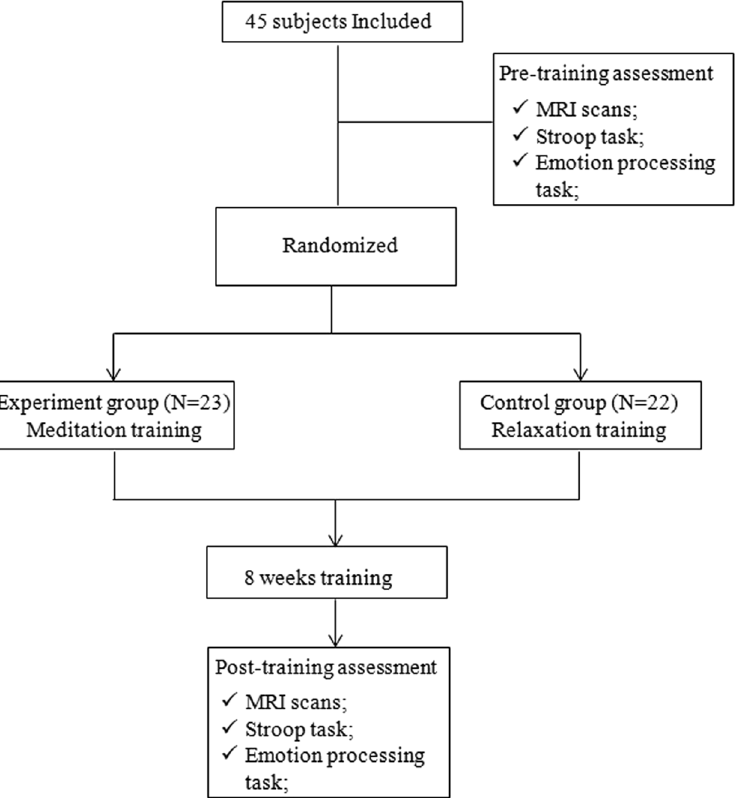
Figure 1. Flowchart of participant flow. Data from 23 subjects from the mediation training group (MT) and 22 subjects from the relaxation training group (RT) were initially entered into the analysis. Amongst these subjects, 4 subjects were excluded due to head motions larger than 3 mm or 3 º . Thus, 22 subjects for MT and 19 subjects for RT were entered into the final network construction and